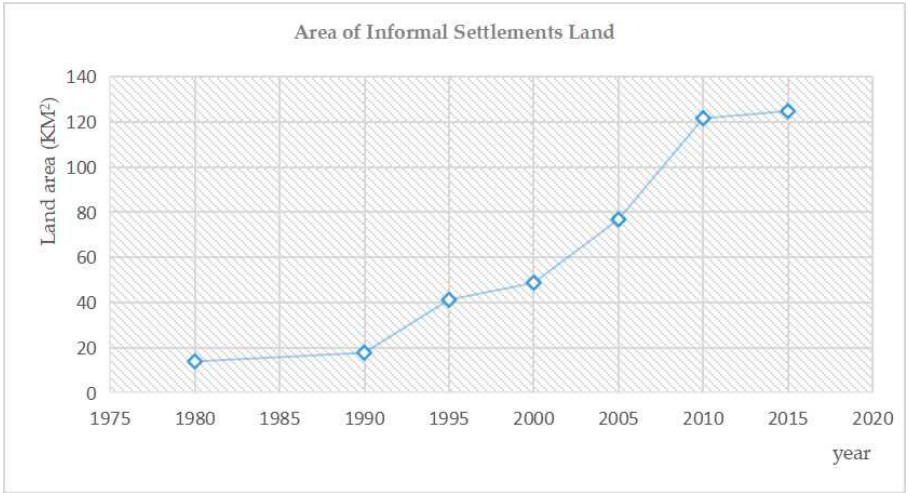
Figure 8. The evolution of land area in informal settlements in the study area. Source: drawn by the authors.